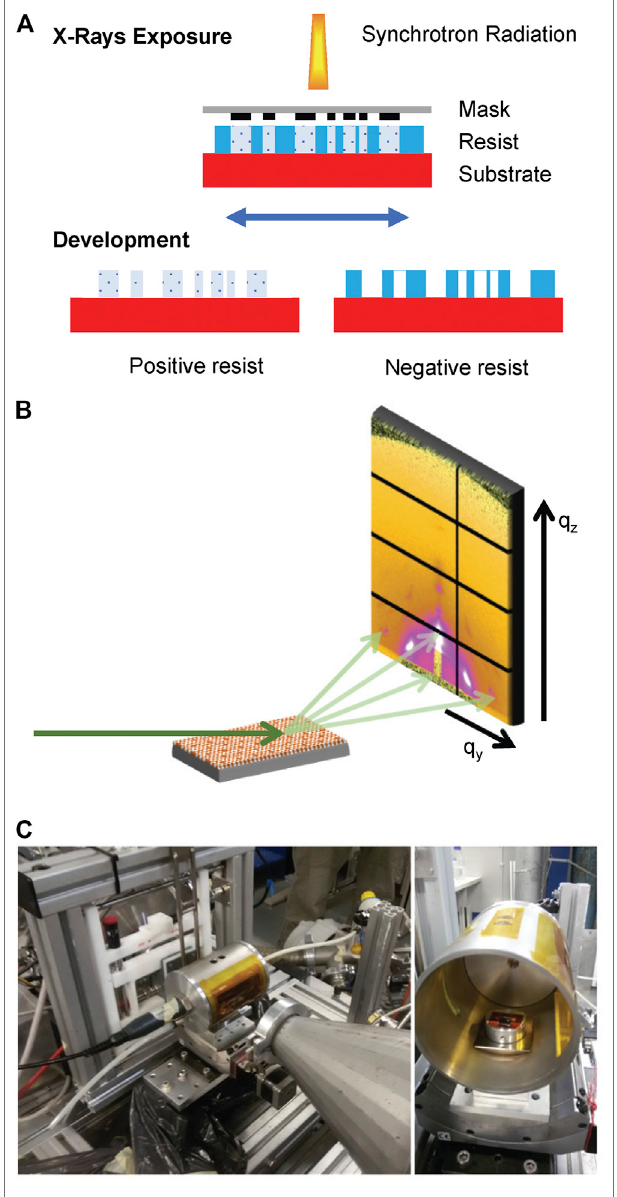
FIGURE 1 | (A) Scheme of the DXRL process, showing the irradiation of both positive and negative resists with synchrotron X-rays. (B) Graphic representation of the GISAXS experiment. X-rays hit the sample at grazing angle, and the scattered photons are collected at the detector. (C) Humidity sample chamber mounted at the Austrian SAXS beamline at